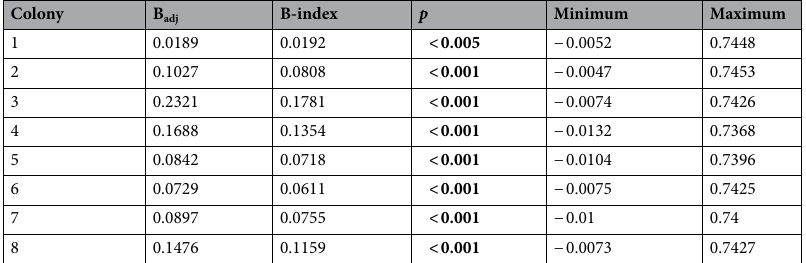
Table 1. Estimates of reproductive skew (B-index values) among queens in polygynous colonies of the Argentine ant. Positive values indicate skewed reproduction, negative values indicate shared reproduction, and values equal to zero indicate random reproductive skew. In bold are the results that differed significantly from zero. Minimum: value indicating that egg-laying is completely equal; maximum: value indicating that egg- laying is monopolized by one queen.